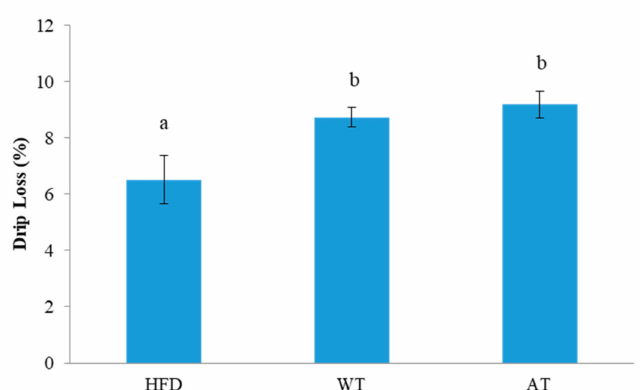
Figure 1. Drip loss analysis of 12 samples of frozen-fillet chub mackerel ( Scomber japonicus ) in different thawing methods. Data are presented as mean ± SD. Different superscript letters (a,b) show significantly different values according to Duncan’s test ( p < 0.05).